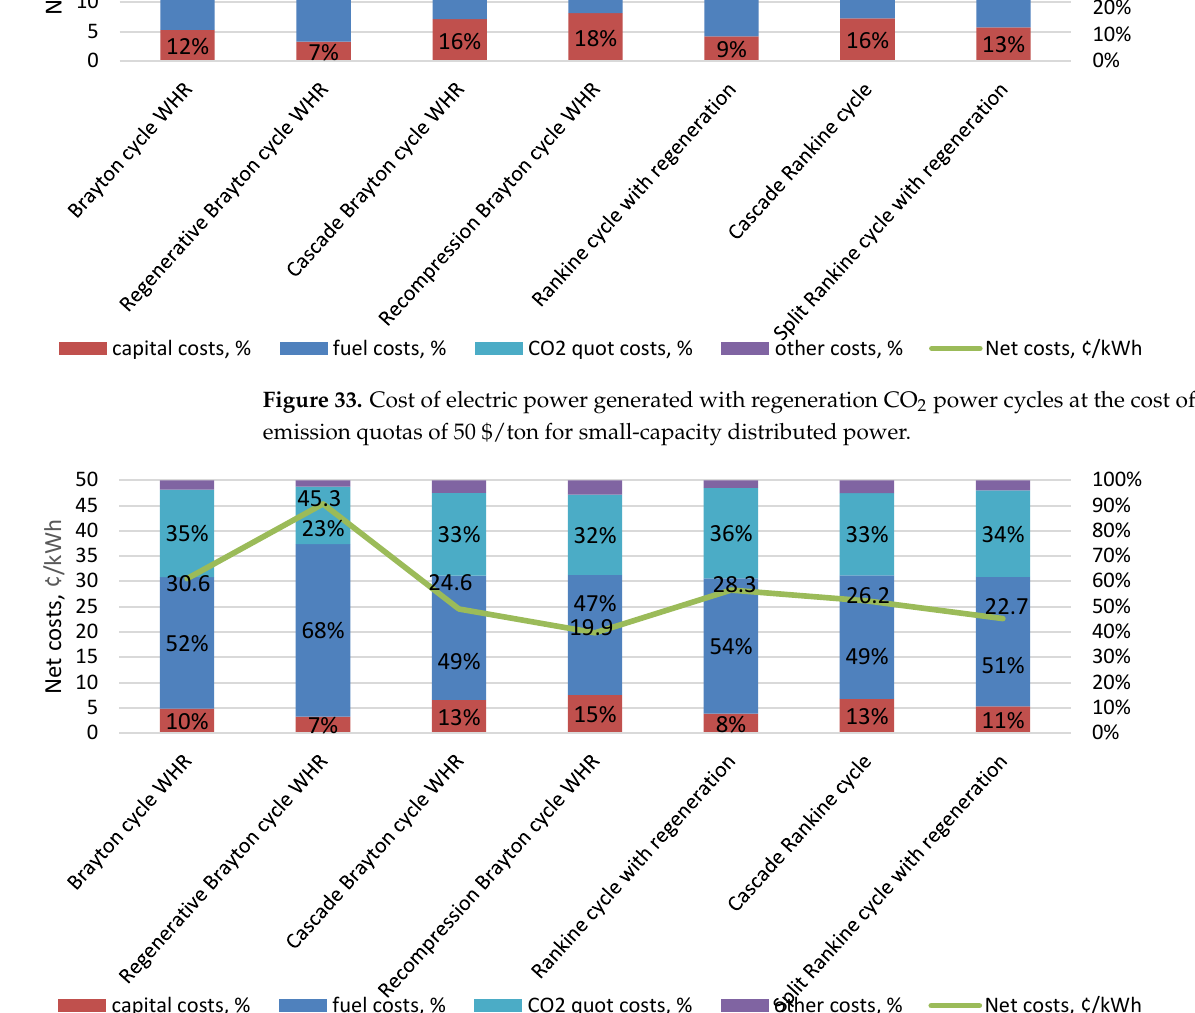
Figure 34. Cost of electric power generated with regeneration CO 2 power cycles at the cost of CO 2 emission quotas of 100 $/ton for small-capacity distributed power.